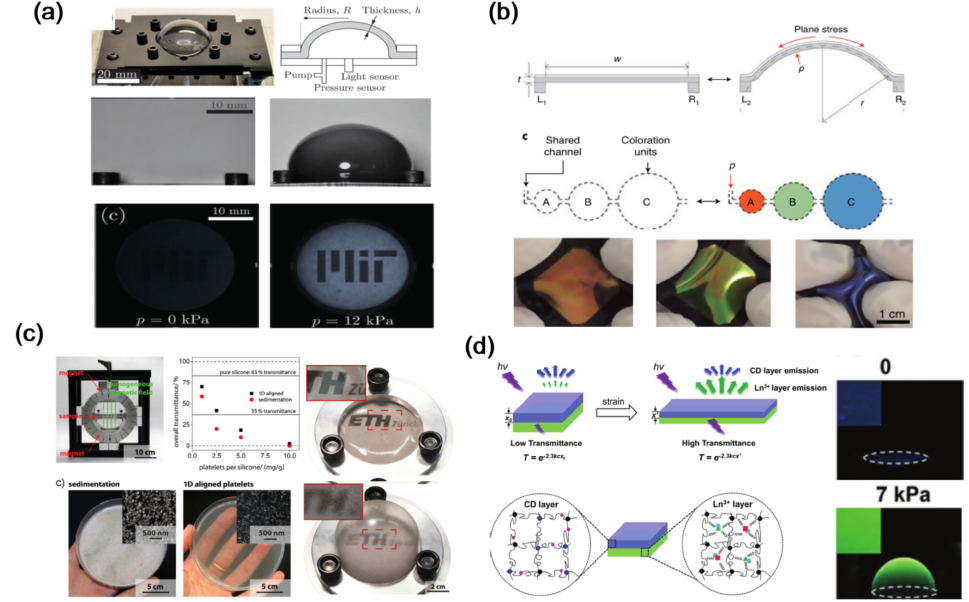
Figure 7. The strategy of pneumatic drive mode mechanoresponsive smart windows: ( a , b ) adjust transparency and color by changing film thickness [45,46] Copyright 2016, John Wiley and Sons and 2021, Springer Nature, ( c ) pneumatic stretching to adjust transparency [47] Copyright 2014, John Wiley and Sons, ( d ) pneumatic drive mode mechanochromic hydrogels [48] Copyright 2019, John Wiley and